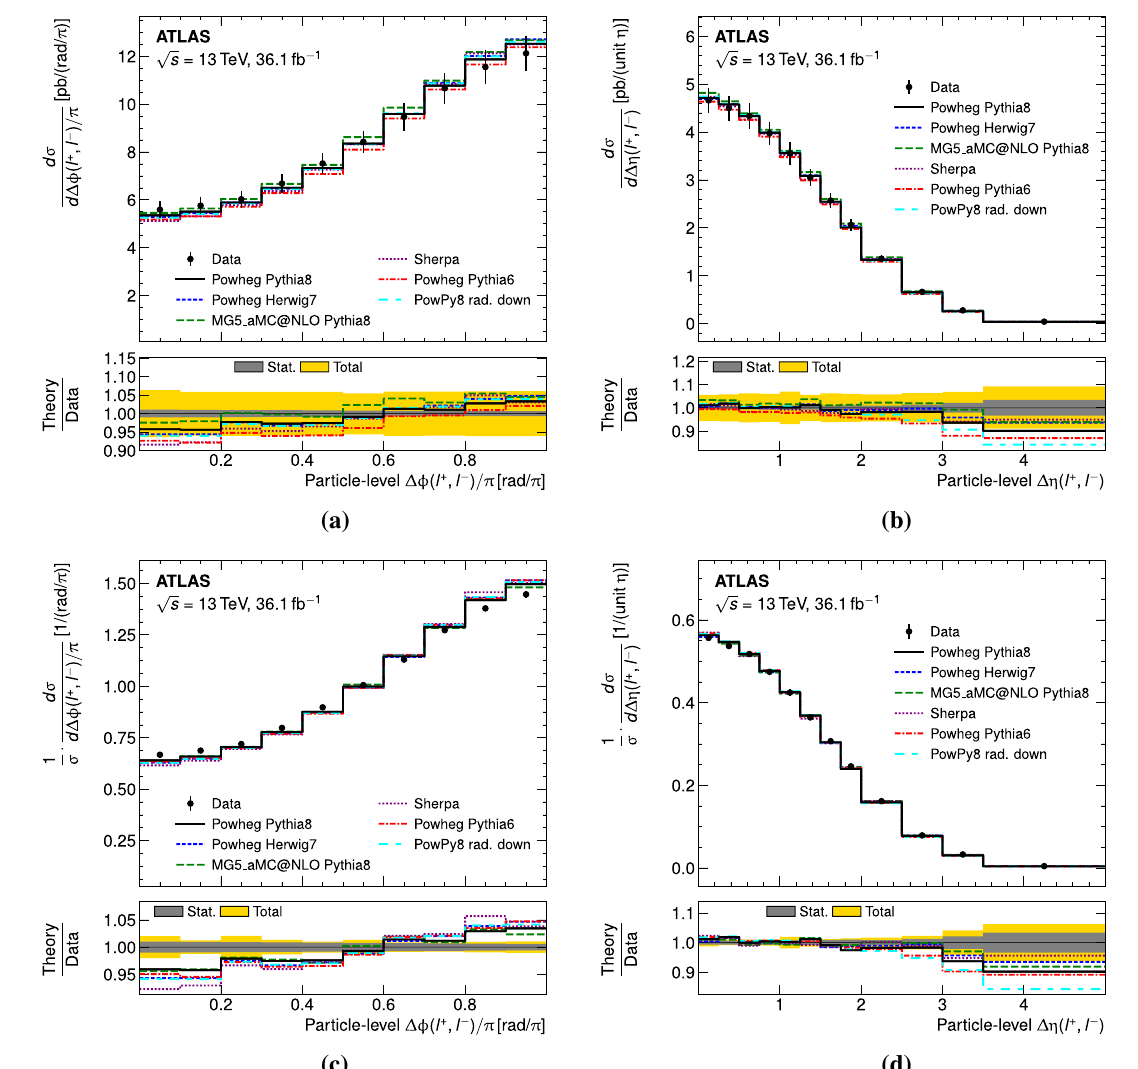
Fig. 10 The fiducial particle-level differential cross-sections compared to predictions from Powheg , MadGraph5 _aMC@NLO and Sherpa : (top) , absolute a (cid:3)φ and b (cid:3)η and (bottom) , normalised c (cid:3)φ and d (cid:3)η , using the inclusive